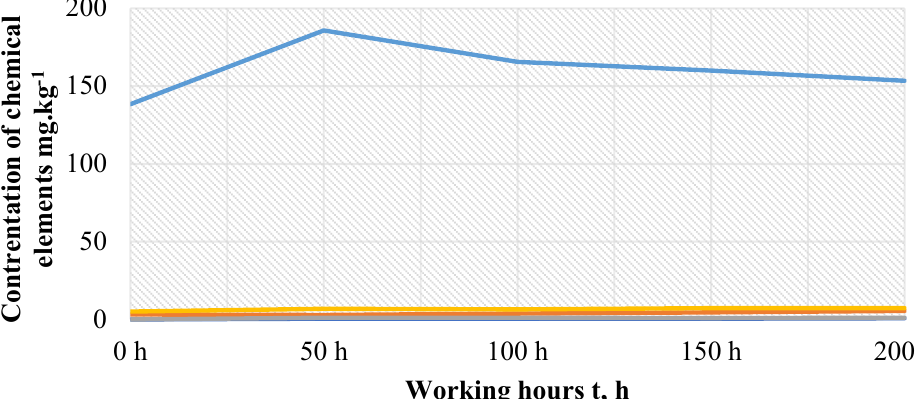
Figure 4. Graph of atomic emission spectrometry after 200 h from the point of view of additives. Table 3. Atomic emission spectrometry from the point of view of additives.